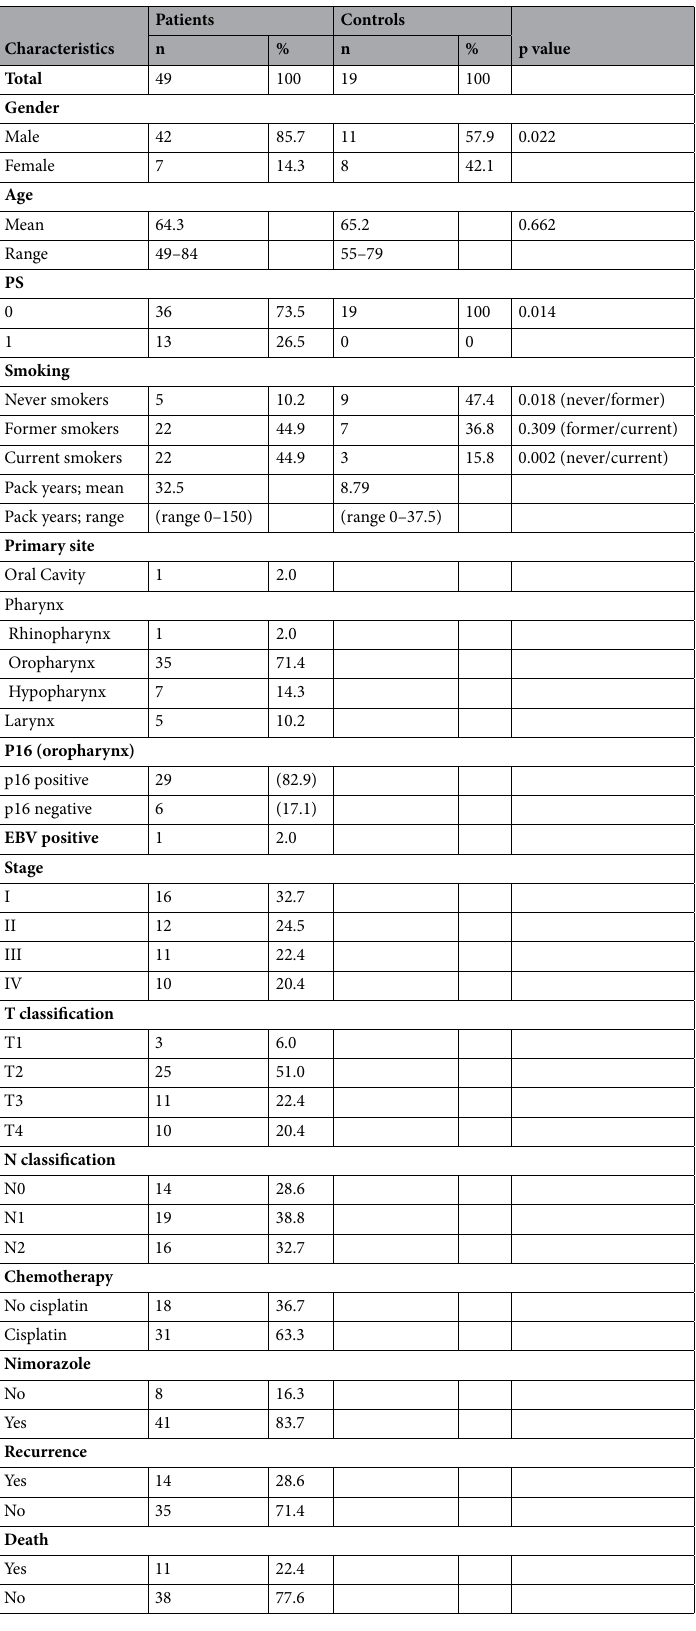
Table 1. Patient and control characteristics. Performance status (PS) according to the WHO classification. Epstein–Barr virus (EBV). Tumor (T). Node